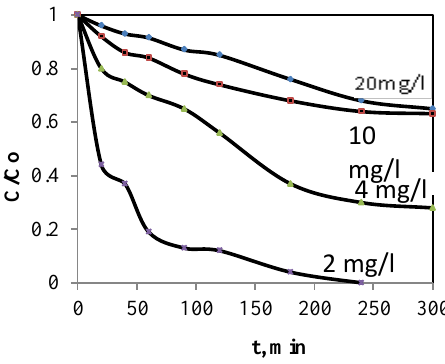
Fig.3. Time variation of Cu(II) adsorption on PSTM-3T at different initial concentrations.